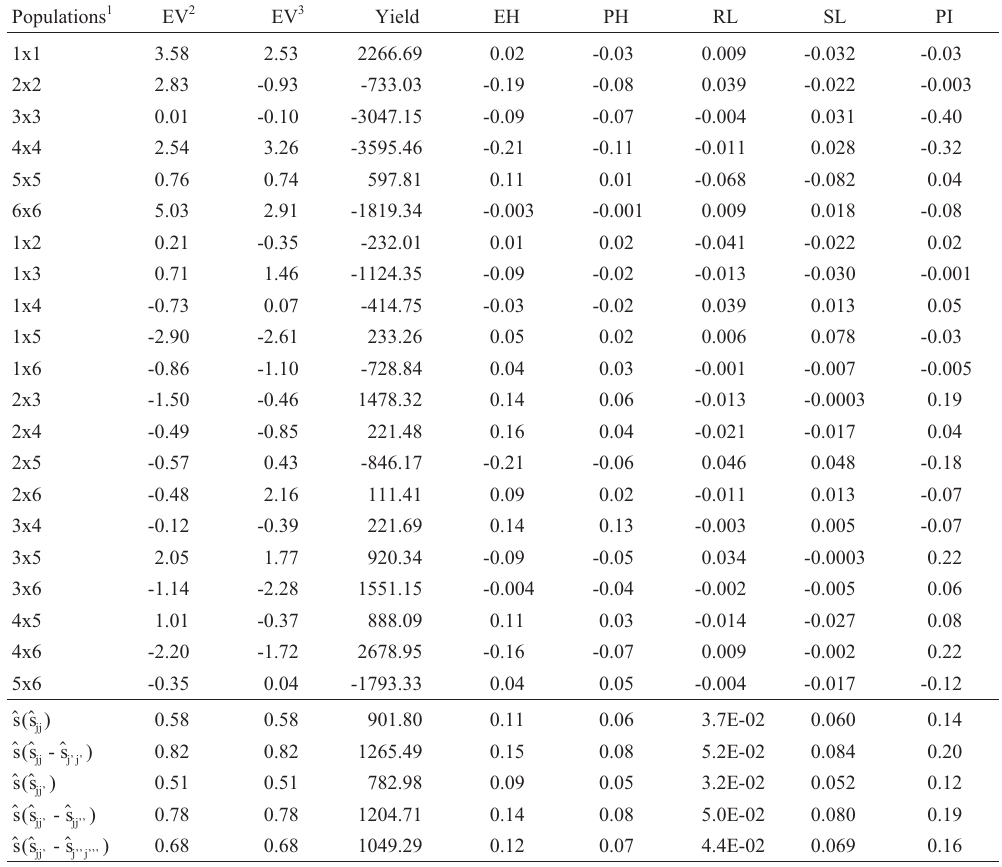
Table 4 - Estimates of specific combining ability effects of popcorn populations for expansion volume (EV, mL/g), yield (kg/ha), plant height (PH, m), ear height (EH, m), proportion of root lodged plants (RL), proportion of stalk lodged plants (SL) and prolificacy index (PI), and standard deviation estimates of the effects and